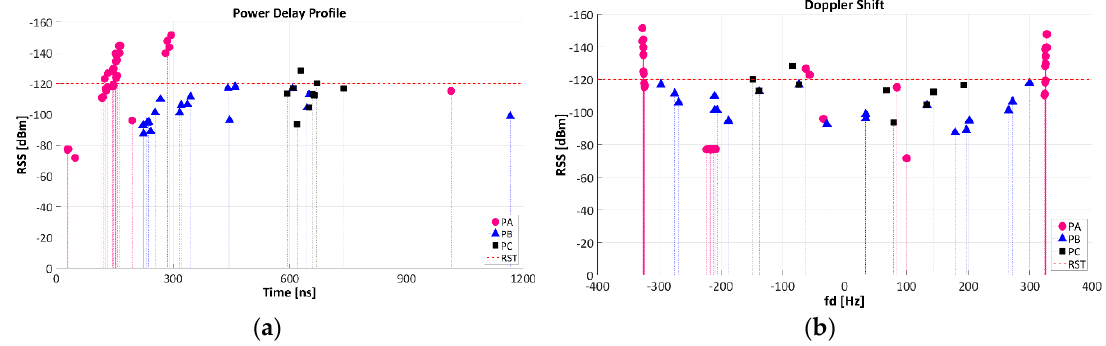
Figure 4. ( a ) Power delay profile (PDP) and ( b )Doppler Shift